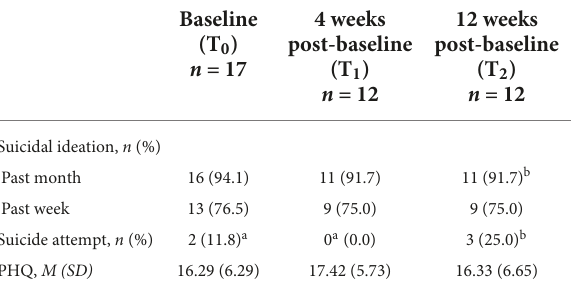
TABLE 3 Clinical characteristics of